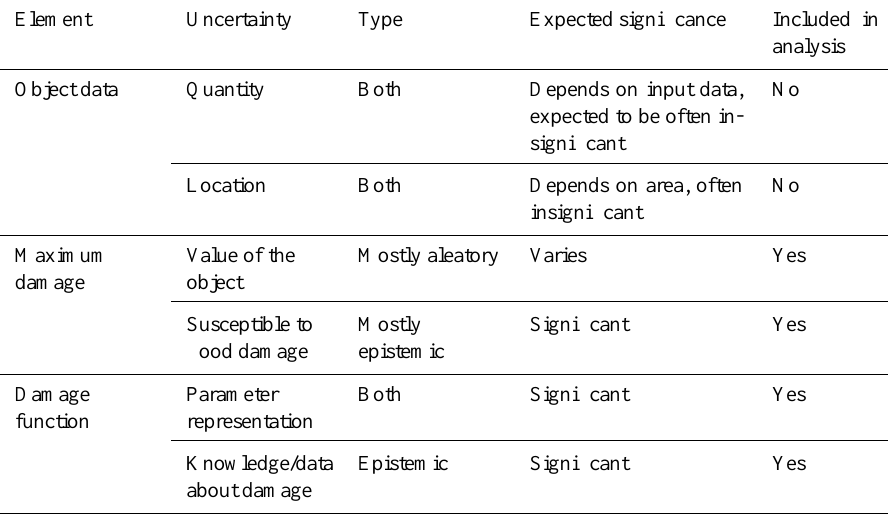
Table 1. Overview of the uncertainties in flood damage modeling.